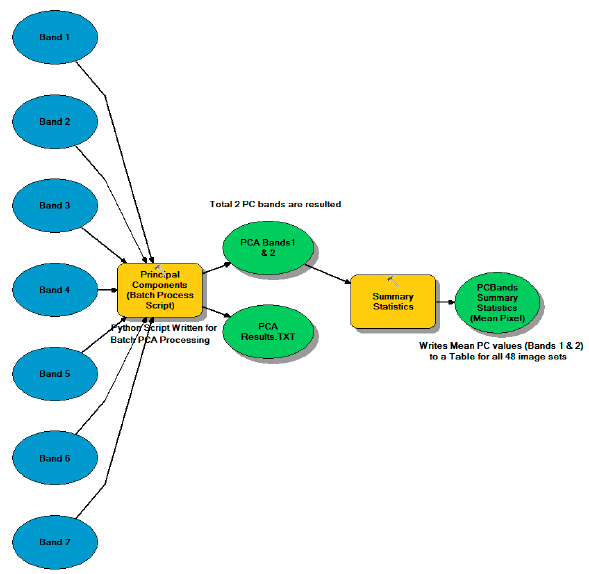
Figure A1. Form developed in VB Studio